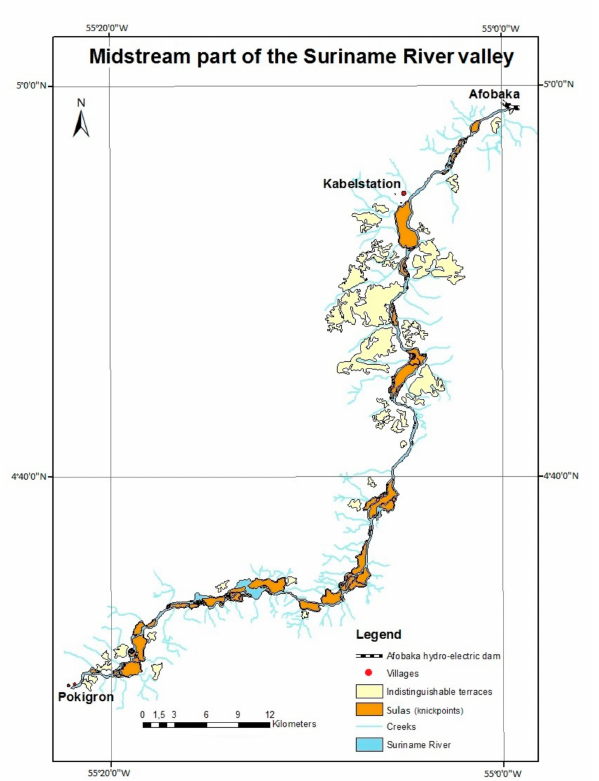
Figure 4. Inferred terraces along the mid-stream river valley part of the Suriname River, now submerged in Lake Afobaka.